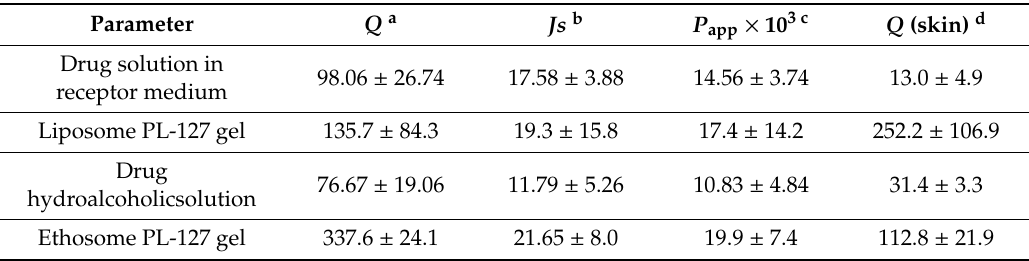
Table 4. Ex vivo permeation parameters of anthralin from di ff erent formulations through rat abdominal